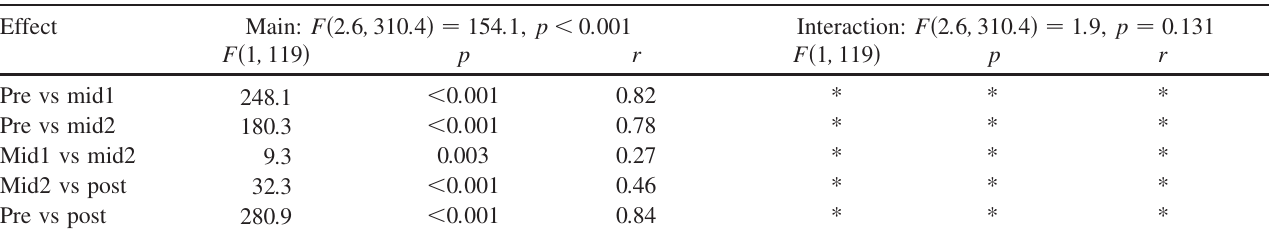
TABLE III. Repeated measure analysis of variance: force subscore. * indicates that the planned contrasts could not be examined. Effect